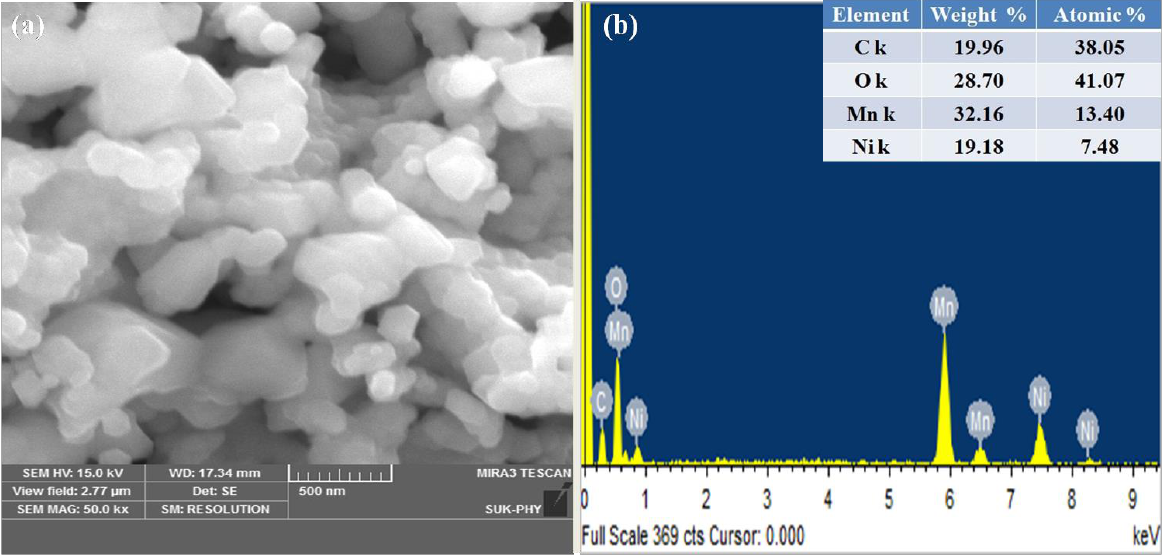
Figure 3. ( a ) FESEM and ( b ) elemental analysis of NMO calcined at 800 